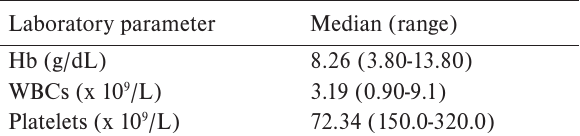
Table 1. Baseline laboratory findings of